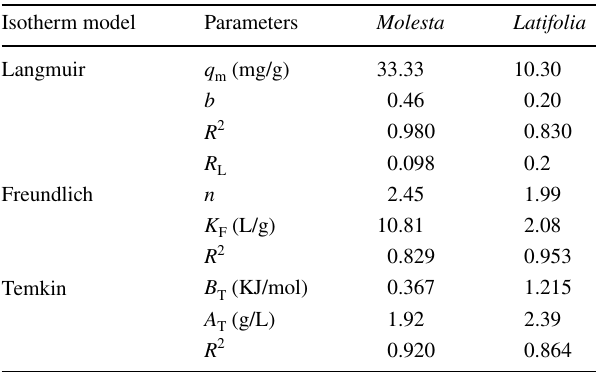
Table 1 Comparison of isotherm parameters for adsorption of Cr 6+ on S. molesta and T. latifolia Isotherm model